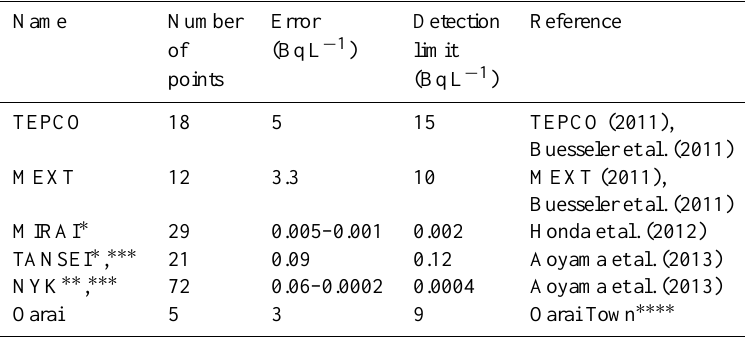
Table 1. Information of 137 Cs observation data obtained for the period from 21 March to 6 May 2011. (Total amount: 417 samples.)